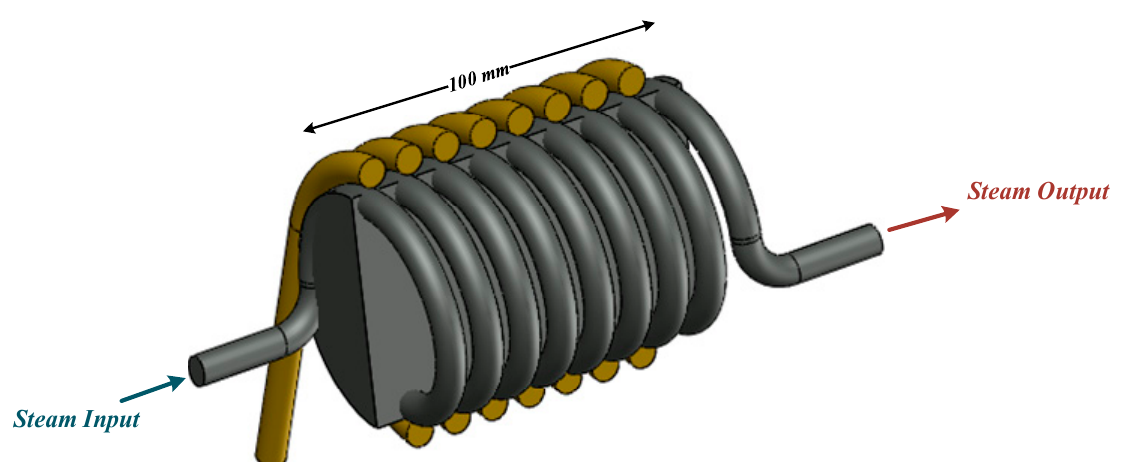
Figure 6. Shape of the proposed heating object.